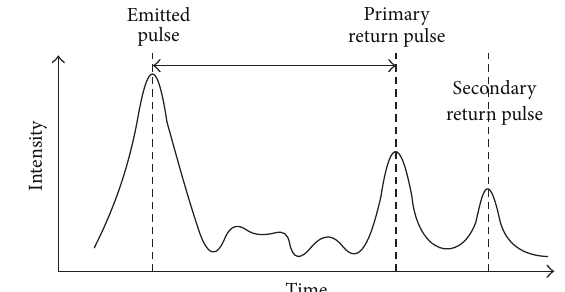
Figure 1: Time of flight measurement system operation principle, where the distance is calculated dividing by 2 the time elapsed between the emitted pulse and the primary or secondary return pulse. Modified from San Jose Alonso et al. [34].